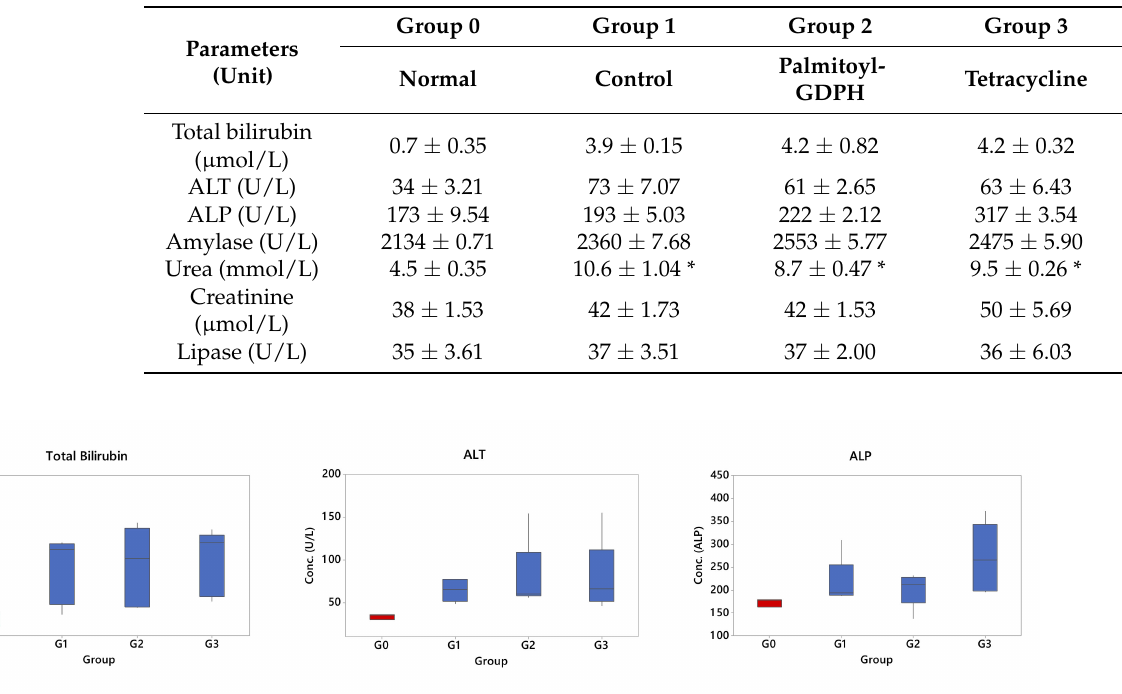
Table 6. Chemistry analysis data for indicators of organ function in blood. Values are expressed as mean ± SD. The asterisks (*) represent significant difference (* p < 0.05) from normal group.